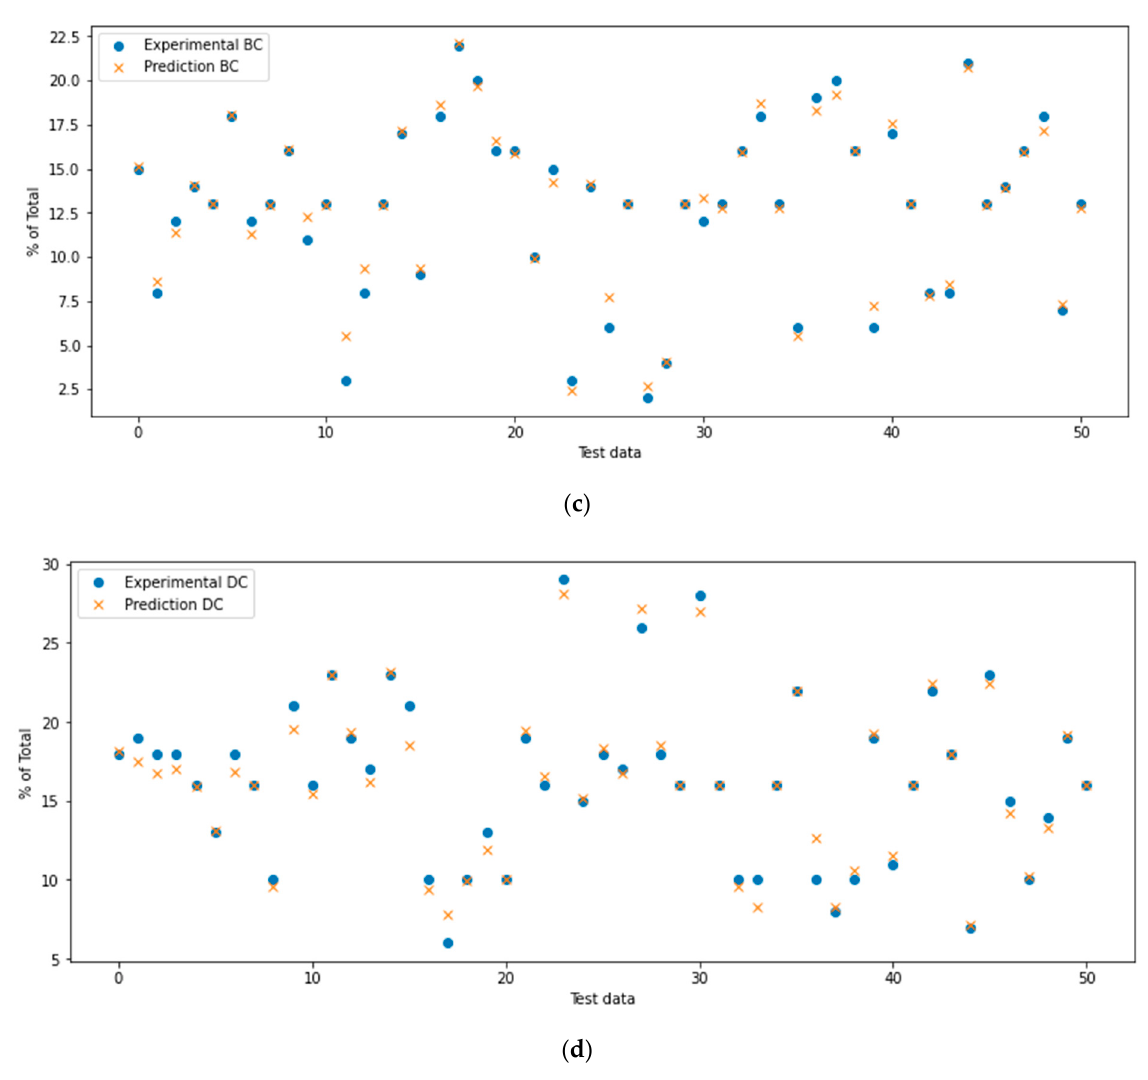
Figure 5. ( a ) ANN 1; ( b ) ANN 2; ( c ) ANN 3; ( d ) ANN 4.